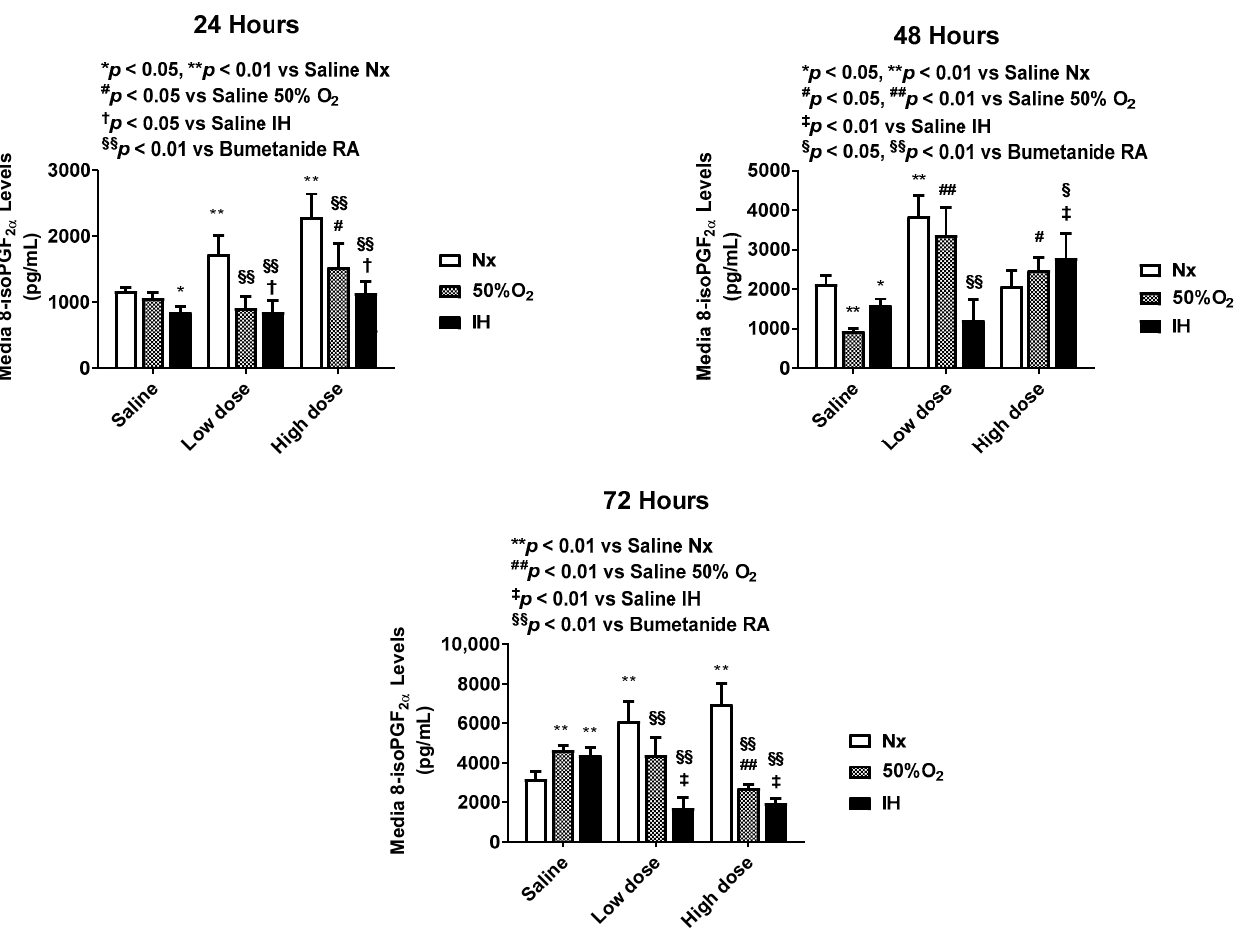
Figure 1. Dose-response effect of bumetanide on 8-isoPGF 2 α levels in the media from cultured human microvascular retinal endothelial cells (HMRECs) exposed to normoxia (white bar), hyperoxia (50% O 2 , shaded bar), or intermittent hypoxia (IH, black bar) for 24, 48, or 72 h. Data were analyzed using two-way ANOVA with Dunnett’s post hoc test. Data are mean ± SEM (8 samples/group). * p < 0.05, ** p < 0.01 versus saline RA; # p < 0.05, ## p < 0.01 versus saline 50% O 2 ; † p < 0.05, ‡ p < 0.01 vs. saline IH; and § p < 0.05, §§ p < 0.01 versus bumetanide treatment in RA.